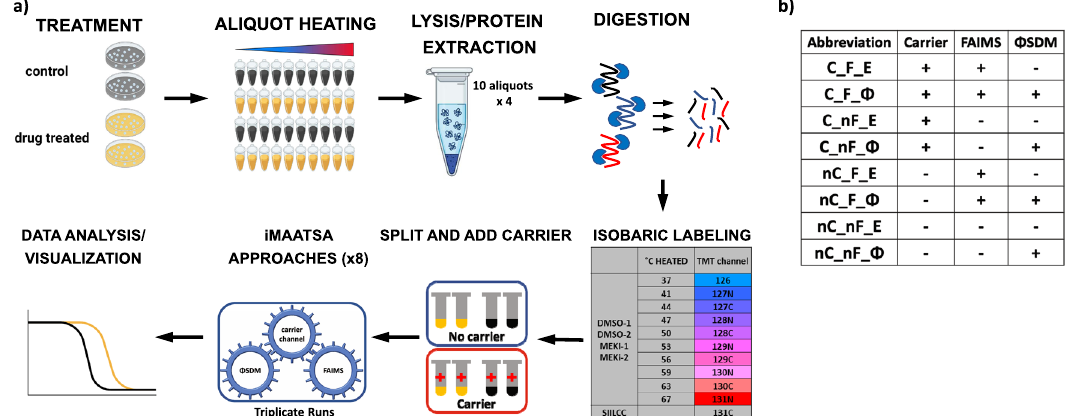
Fig. 1 Experimental work fl ow overview. a Jurkat cell cultures were treated in duplicate with either DMSO or the commercially available MEK inhibitor RO4987655, and aliquots of suspended cells were heated to 10 speci fi c temperatures. Detergent was added, and cells were lysed by freeze-thaw and digested overnight with a trypsin-lysC mixture. Aliquots were labeled with TMT10-plex reagents, pooled, and split into two halves, where one half received an addition of 50 µ g of SDS-solubilized Jurkat cell lysate as a stable isotope isobarically labeled carrier channel (SIILCC). Samples were analyzed using eight iMAATSA approaches. b Abbreviations used for the combinations of technologies for eight iMAATSA that were